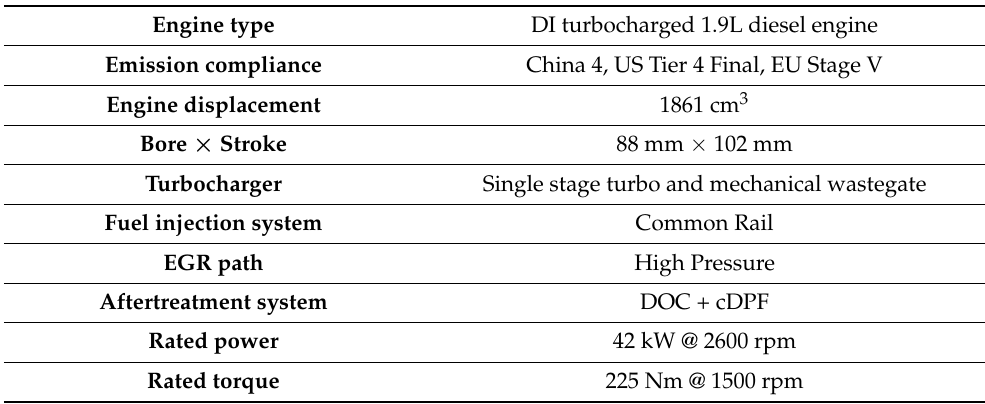
Table 2. Main features of the test engine “Kohler KDI 1903 TCR”.